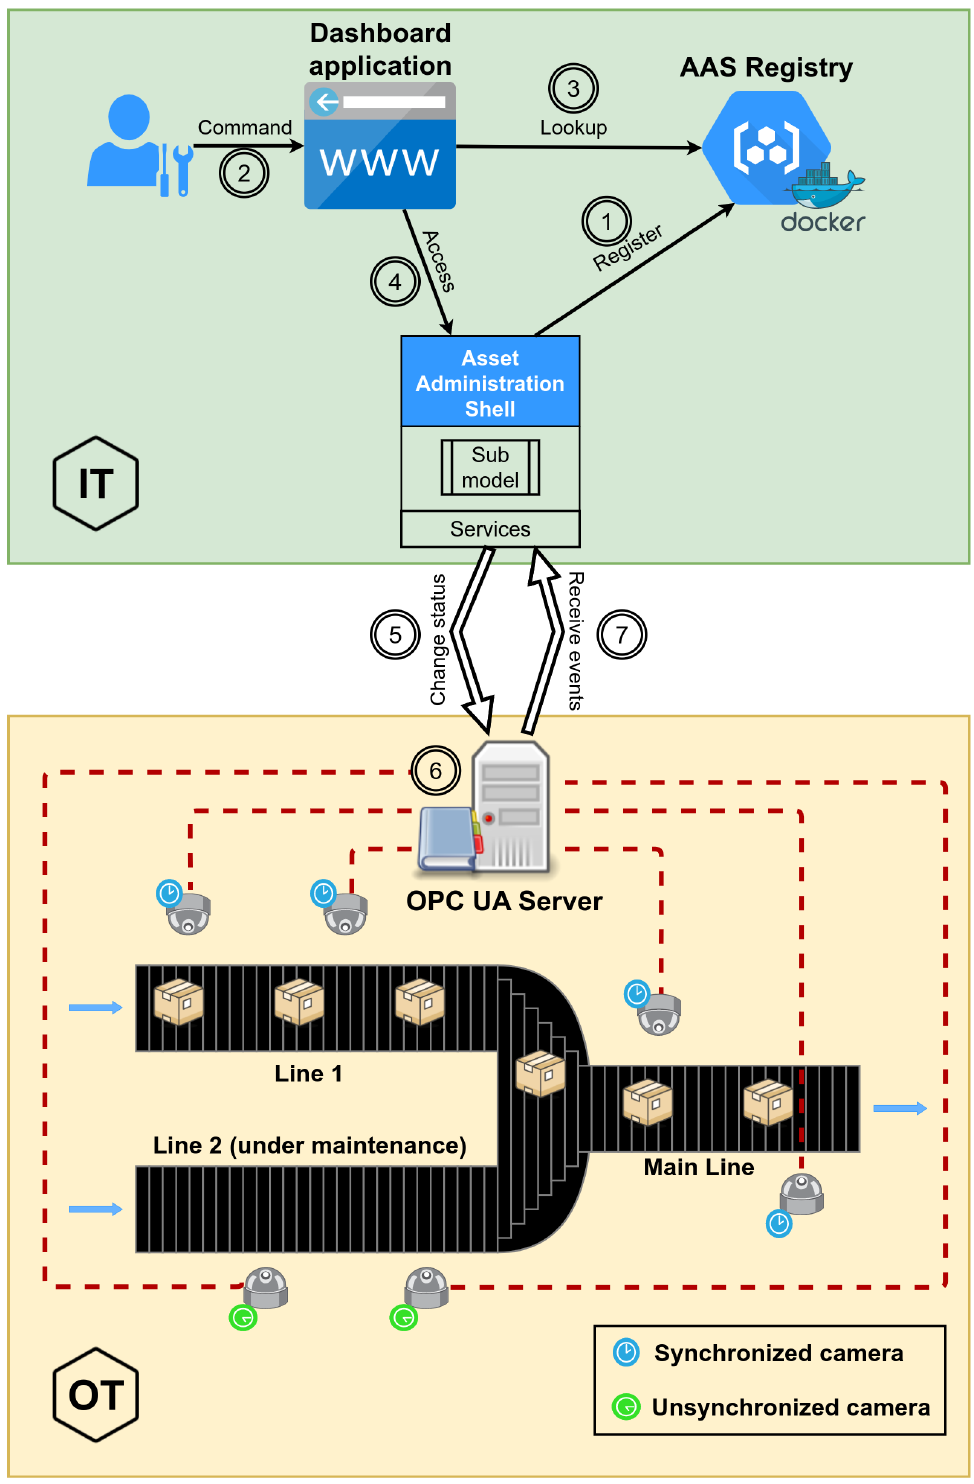
Figure 2. Asset Administration Shell Software Architecture applied to OT scenarios. The IT and OT worlds are isolated from each other with AAS and the OPC UA server as the gateway between the two. In the OT, a physical representation of the case study is depicted, in which packages flow from left to right, from the two belts to the singular one. Synchronization is required to ensure the correct behavior of the